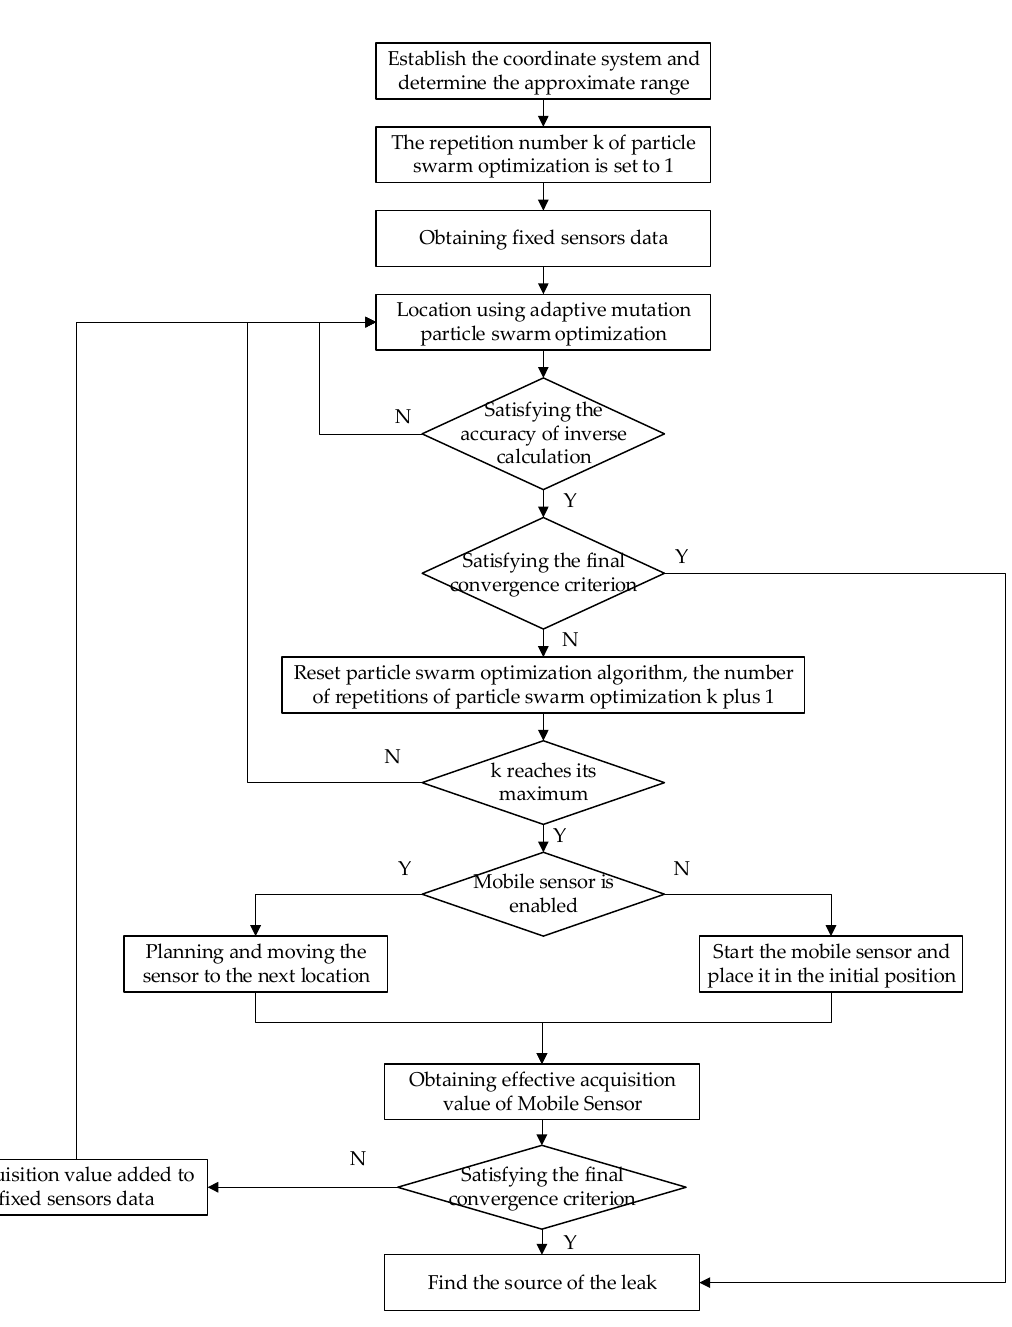
Figure 4. Flowchart of collaborative leak source localization algorithm for mobile sensor and fixed sensor network.